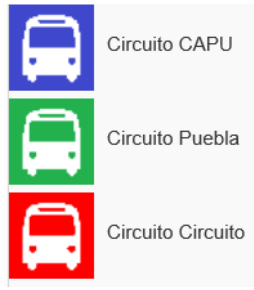
Figure 3. UDLAP Buses Routes.